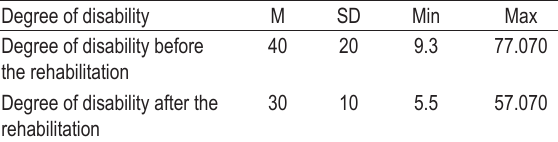
TABLE 5. Degree of disability before and after the rehabilitation